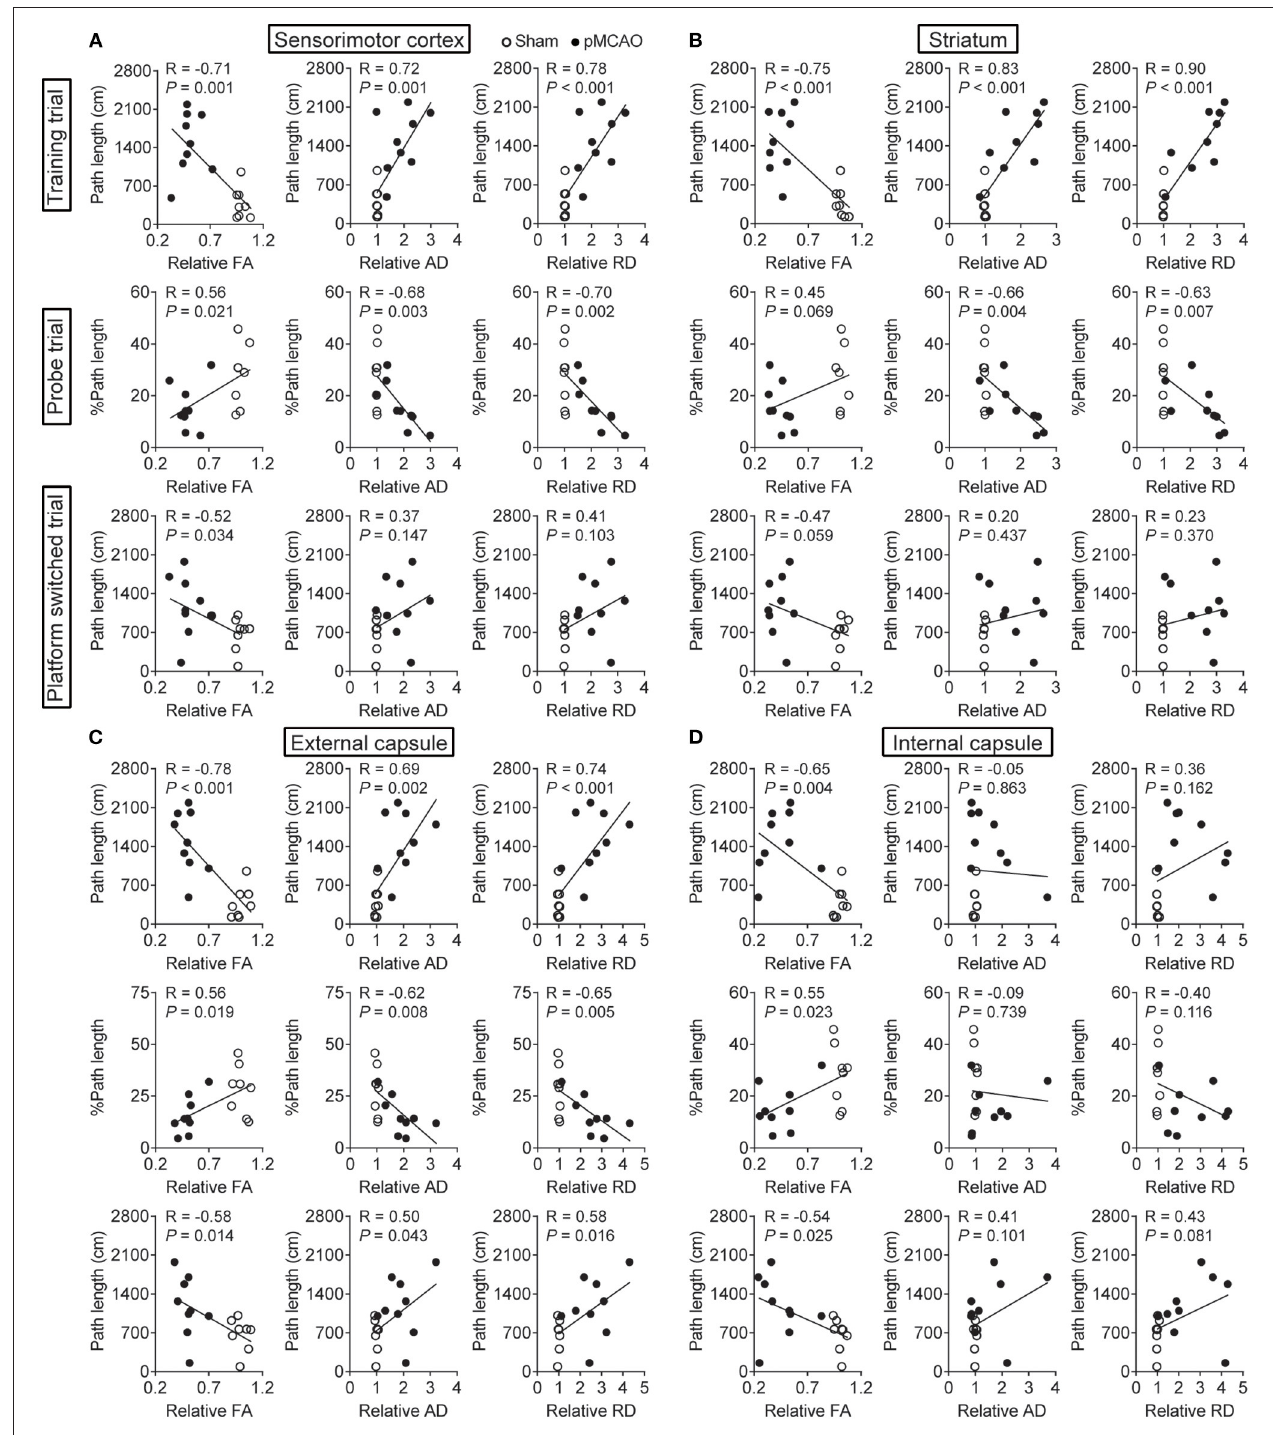
FIGURE 7 | pMCAO induced cognitive impairments were correlated to gray and white matter injuries in rats. Correlational analysis between the MWM data and DTI parameters obtained from the (A) sensorimotor cortex, (B) striatum, (C) external capsule, and (D) internal capsule.